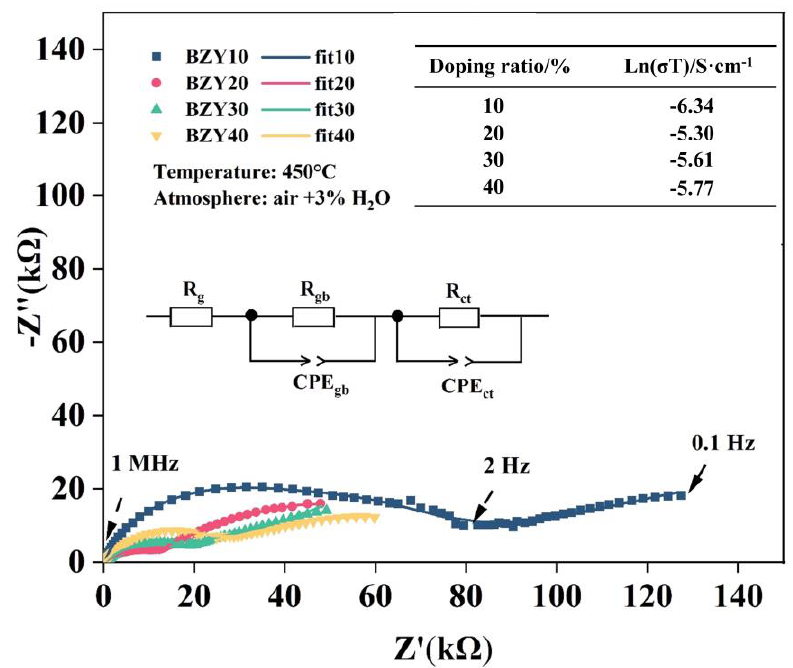
Figure 11. Nyquist plot of BZYs in a humid air atmosphere and at 450°C. The conductivity of BZYs with different yttrium doping contents is shown in the top right table.